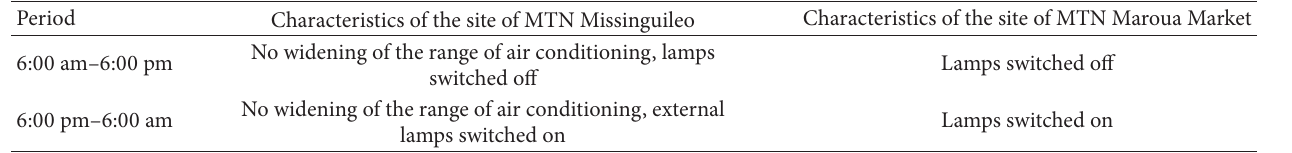
Table 8: Proposals of energy savings on the lighting and air conditioning aspects of MTN sites. Characteristics of the site of MTN Maroua